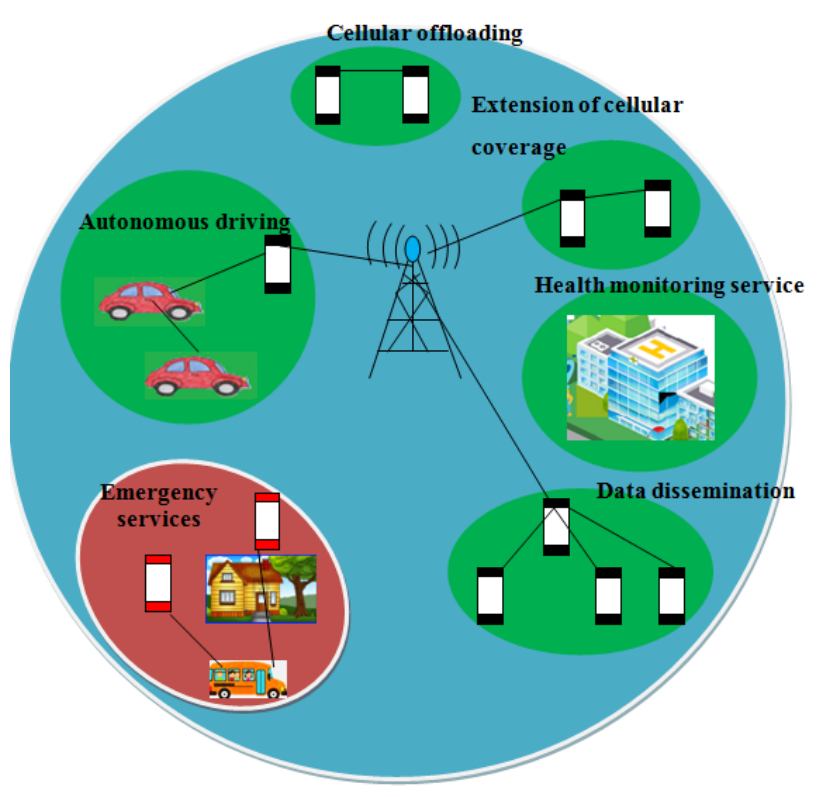
Figure 2. D2D communication: Use